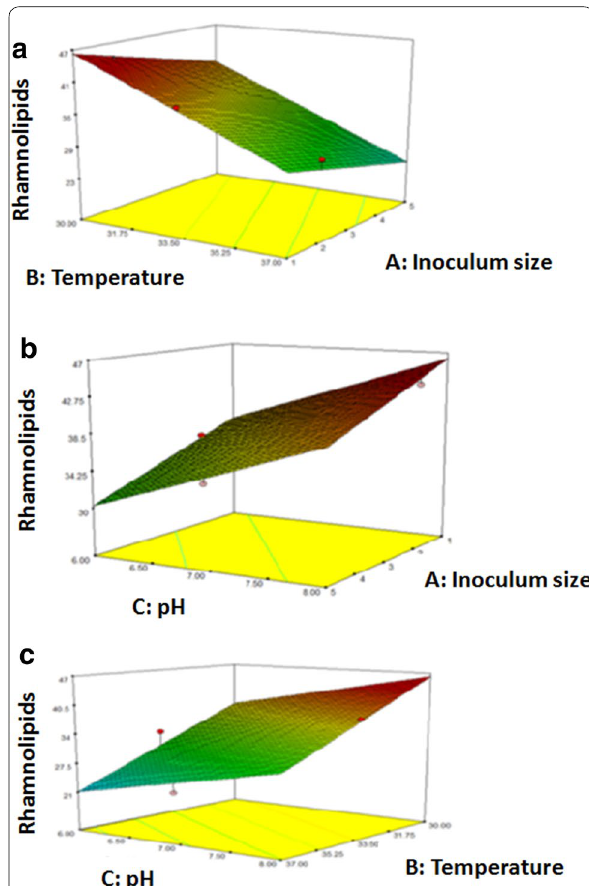
Fig. 4 Three dimensional (3D) surface plots for the effects of temperature, inoculum size and pH on RL production by P. aeruginosa 15GR using SSF (obtained from Design Expert software). a pH is fixed at 8, b Temperature is fixed at 30 °C, c Inoculum size is fixed at 1%